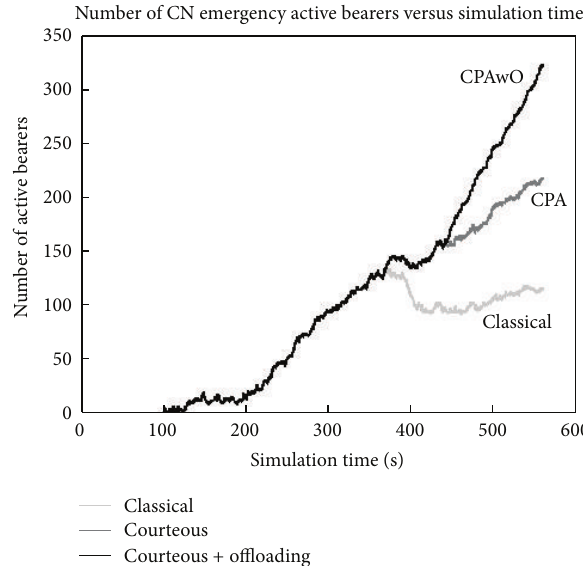
Figure 8: Number of CN nonemergency blocked